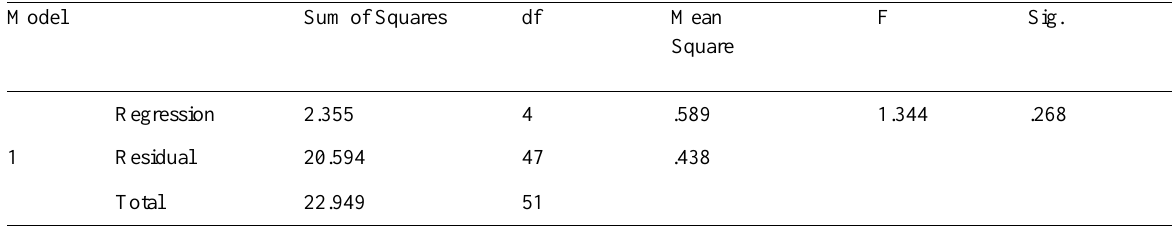
Table 6: Analysis of Variance